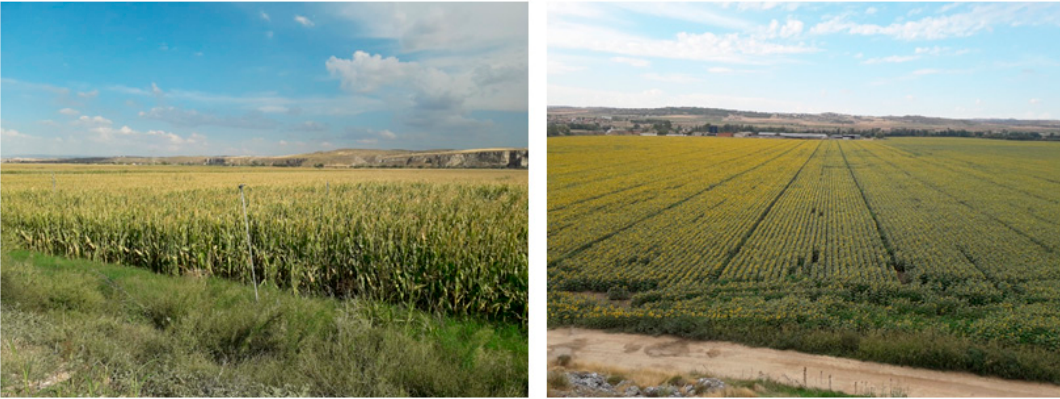
Figure 7 . Forage crops (maize on the left, sunflowers on the right), in large-scale farms with irrigation on the alluvial plain of the River Tajo. on the alluvial plain of the River